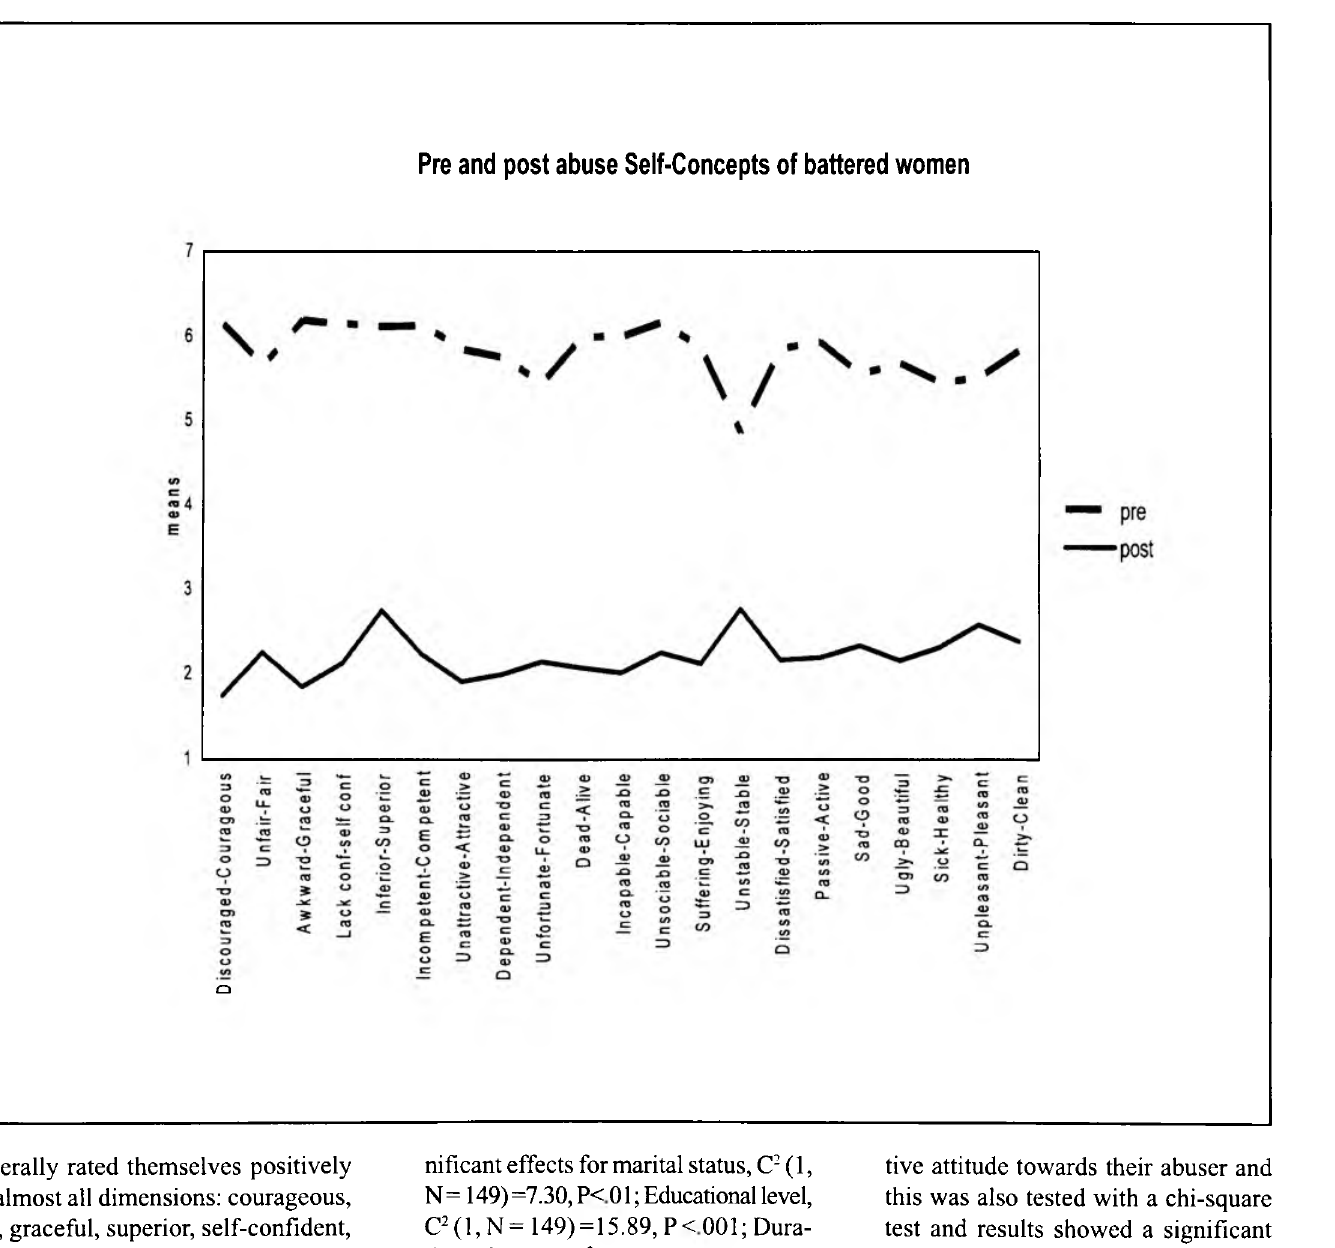
Figure 1: Pre and post abuse Self-Concepts of battered